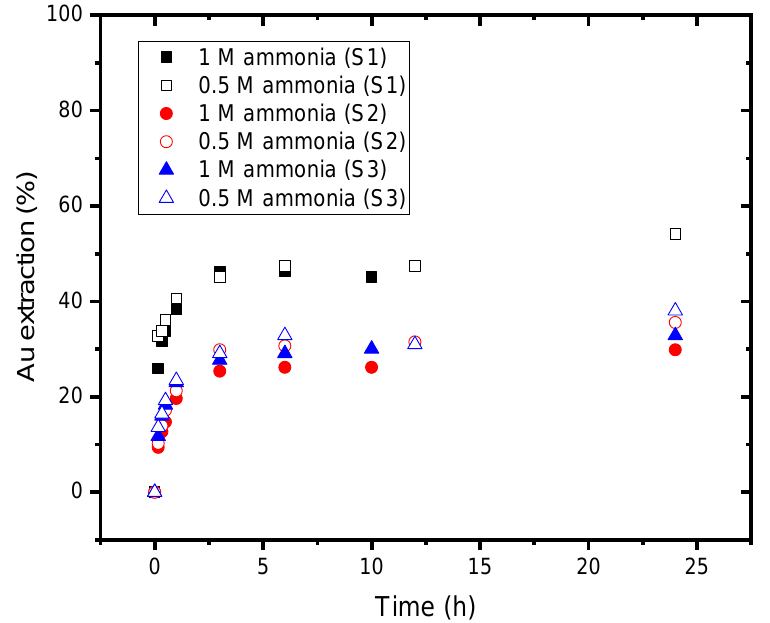
Figure 17. Effect of varying NH 3 concentrations on gold extraction for Sample 1 (S1), Sample 2 (S2), and Sample 3 (S3) at 0.5 M (NH 4 ) 2 S 2 O 3 and 1 mM Cu (30% solids, −300 + 150 µm PSD, 26 °C).